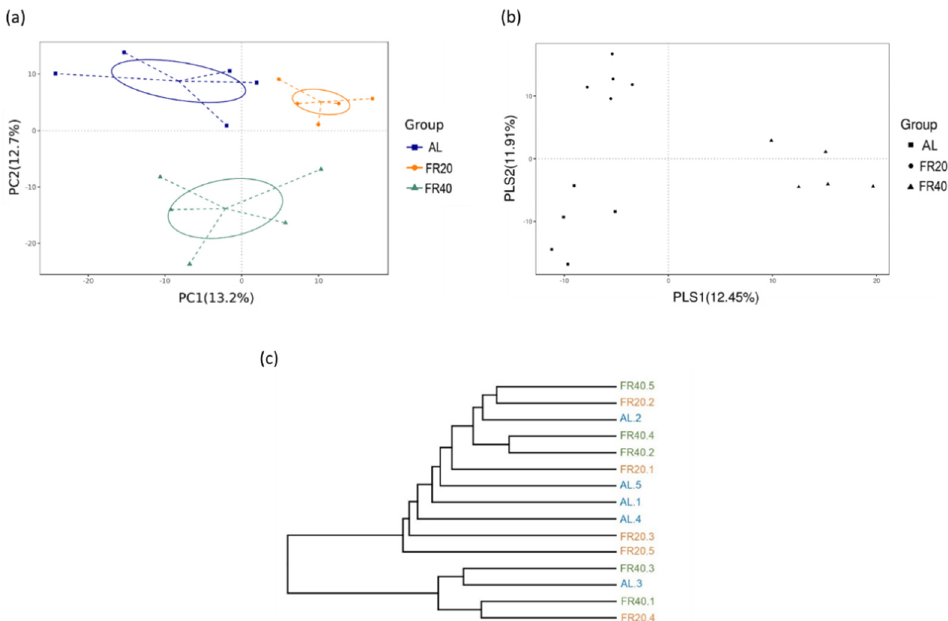
Figure 5. The similarity of the identified OTU among each group: ( a ) Principal components analysis (PCA) of the bacterial community structure among AL (square—blue color), FR20 (circle—orange color), and FR40 (triangle—green color). Each symbol represents each gut microbiota; ( b ) partial least squares discriminant analysis (PLS-DA). Each symbol represents each gut microbiota. Square symbol represents AL group, circle symbol represents FR20, and triangle symbol represents FR40; ( c ) Simple agglomerative hierarchical clustering method based on WPGMA. AL: ad libitum with basal diet; FR20: basal diet with 20% feed restriction; FR40: basal diet with 40% feed restriction.